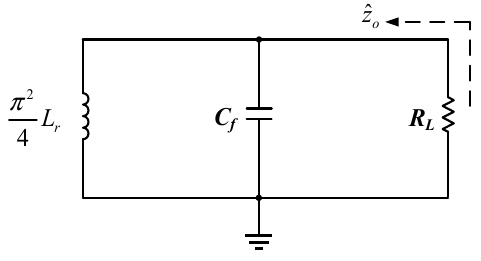
Figure 3. Output impedance equivalent circuit of LLC converter.